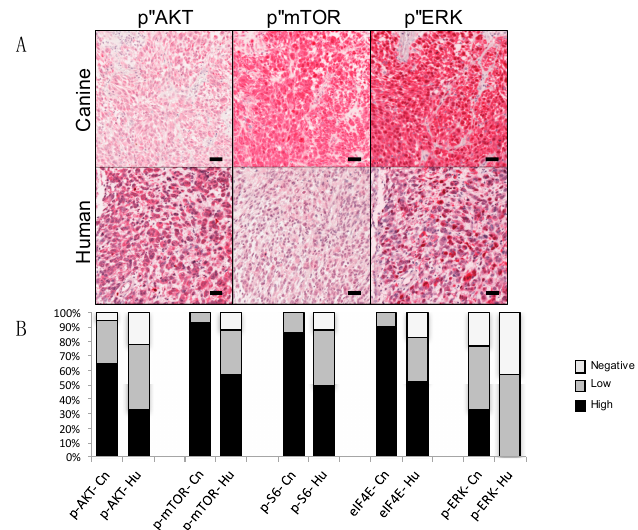
Figure 3. Activation of ERK and PI3K/AKT/mTOR signal transduction pathways in human and canine mucosal melanoma detected by immunohistochemistry on primary tumor tissue arrays. ( A ) Representative immunopositive reactions for pathway mediators are illustrated. Phospho-specific primary antibody signal detection with red chromogen and hematoxylin counterstain. Bars = 50 μ m. ( B ) Percentages of immunopositive melanomas for selected canine (Cn, n = 43) and human (Hu, n = 40) signal transduction mediators. Relative intensity and percentages of immunolabeled cells were considered in scores, assigned as negative, low, and high. Used by the authors with permission under Creative Commons Attribution License [45].